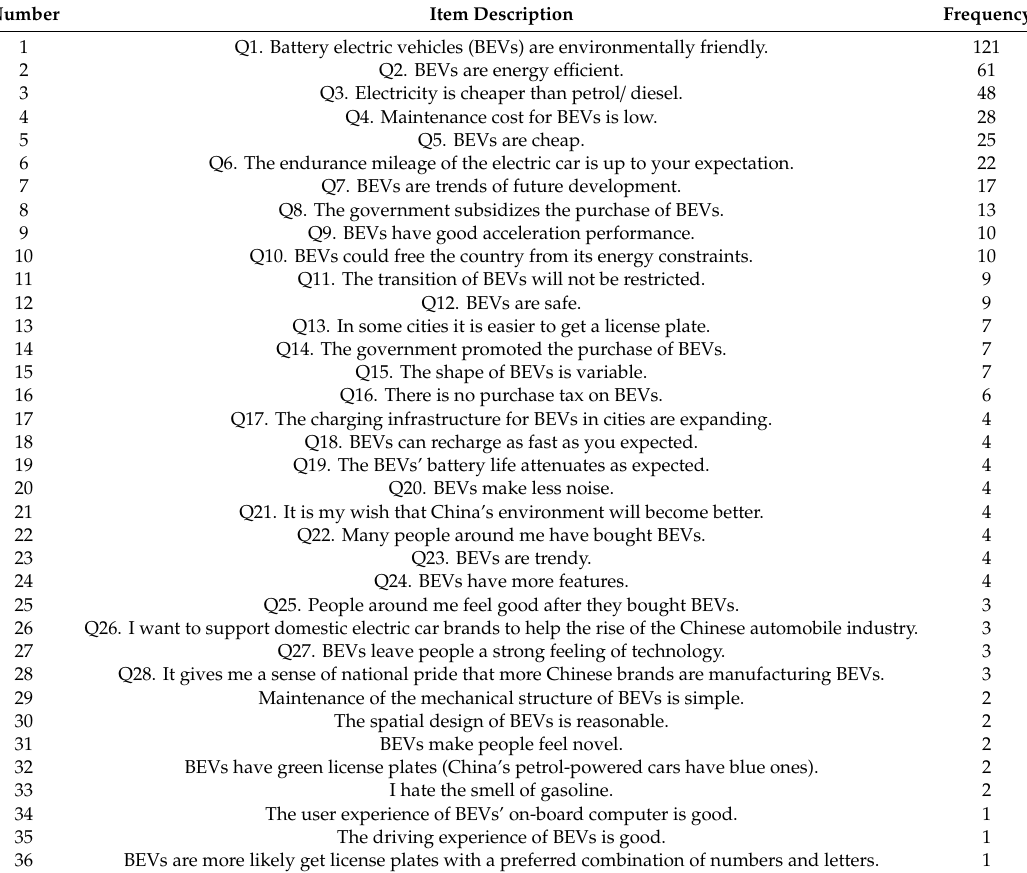
Table 4. Items derived from the first-phase